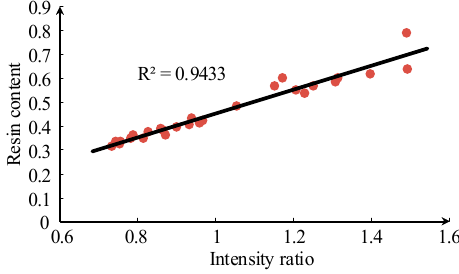
Figure 12. Intensity ratio of Si I 566.5 nm to C II 514.3 nm for samples with different resin content.